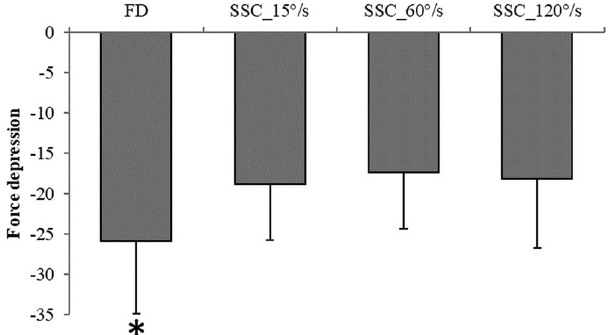
Figure 7. Mean ( ± SE) values of force depression for pure FD tests (FD_60°/s) and for SSC tests performed at 15°/s, 60°/s and 120°/s (SSC_15°/s, SSC_60°/s, SSC_120°/s, respectively) normalized to the values of the isometric reference contraction at the corresponding thumb angle. Force depression without prior stretching was 25.9% ± 2.5% and was significantly greater compared to all SSCs (18.8% ± 2.0%, 17.4% ± 1.9%, 18.1% ± 2.4% for SSC_15°/s, SSC_60°/s, and SSC_120°/s, respectively). However, no significant difference was found between SSCs. ( * Compared to all SSC; p <